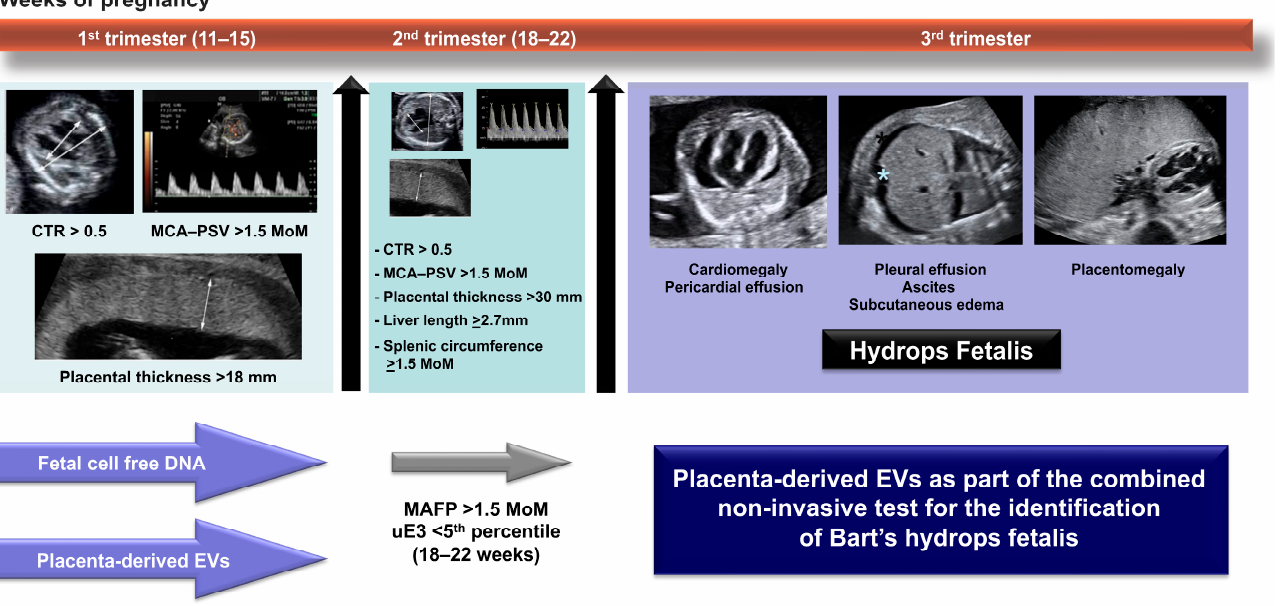
Figure 6. An integrative diagnostic model combining current biomarkers and placenta-derived EVs for the identification of Bart’s hydrops fetalis throughout gestation. CTR: cardiothoracic diameter ratio, MCA-PSV: middle cerebral artery peak systolic velocity, MoM: multiple of median, MAFP: maternal alpha fetoprotein, uE3: unconjugated estriol.